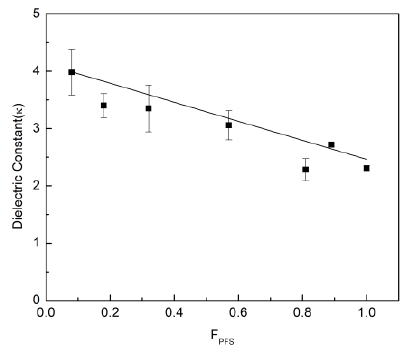
Figure 6. Dielectric constant of copolymer versus copolymer composition, F PFS. The solid line is the line of best fit to the experimental data points.